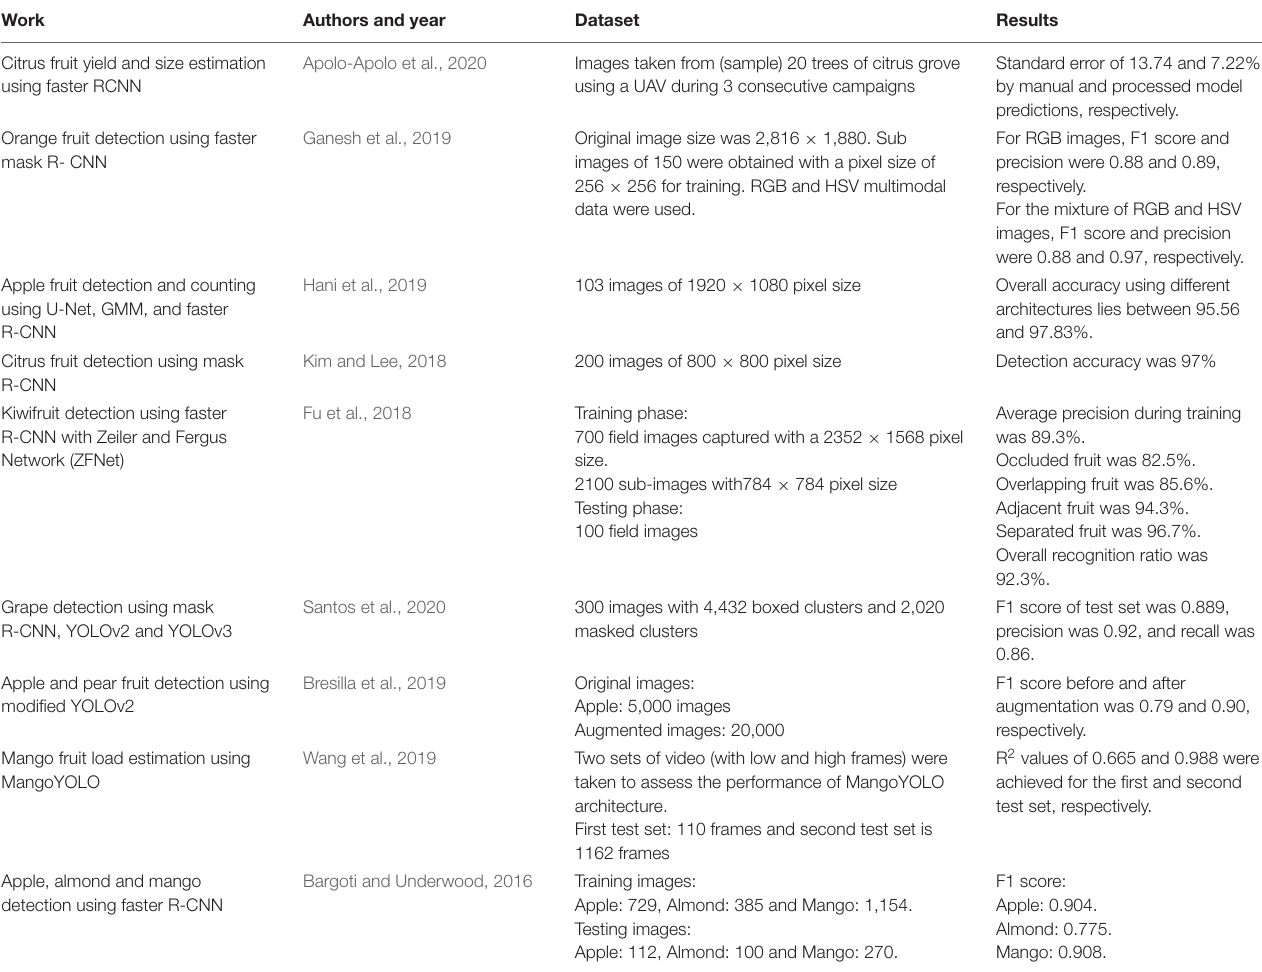
TABLE 4 | Literature studies for fruit yield estimation using the R-CNN and single shot detectors.